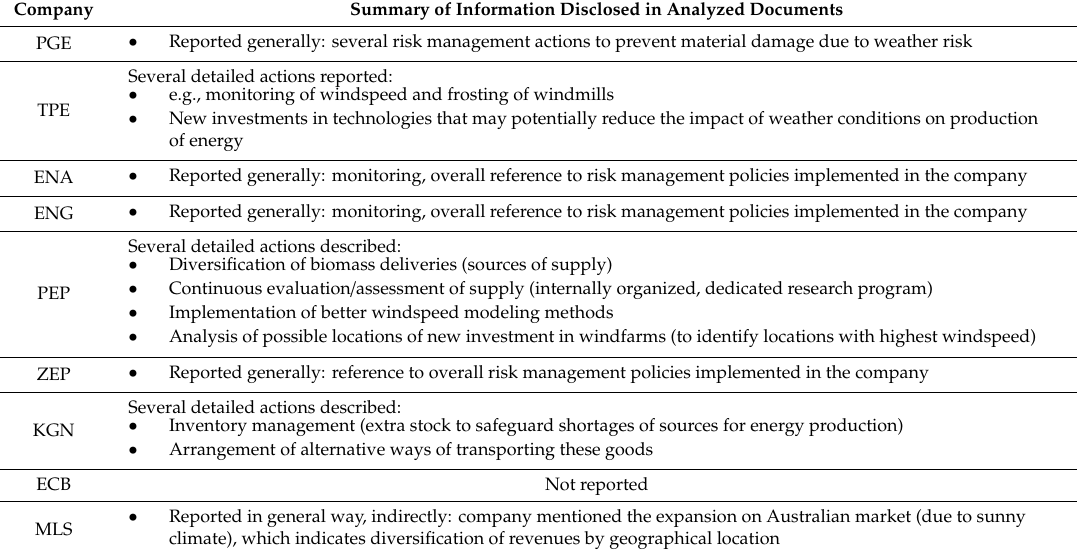
Table A4. Summary of textual data for RQ3: Does the company disclose the information on methods / measures used to hedge / manage weather risk?